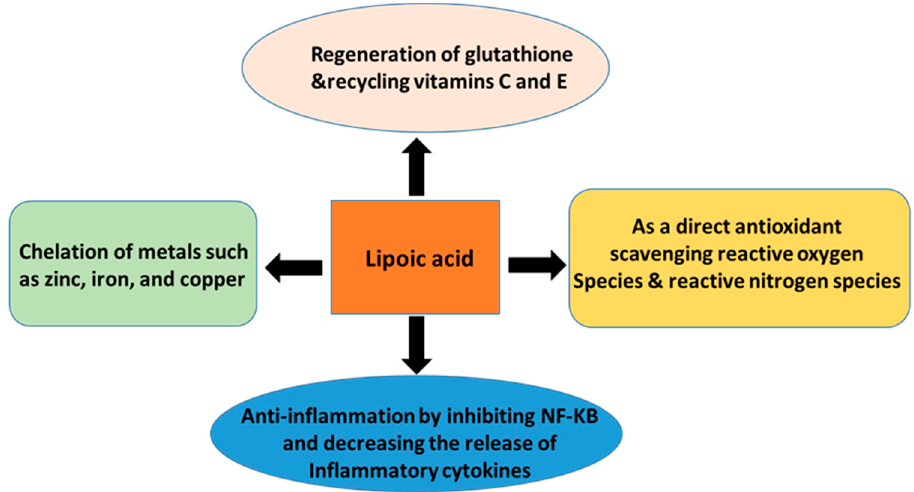
Figure 4. Biological actions of lipoic acid and its potential mechanisms, which include regeneration of glutathione, vitamins C and E, scavenging ROS, chelating metal ions, and anti-inflammatory power.